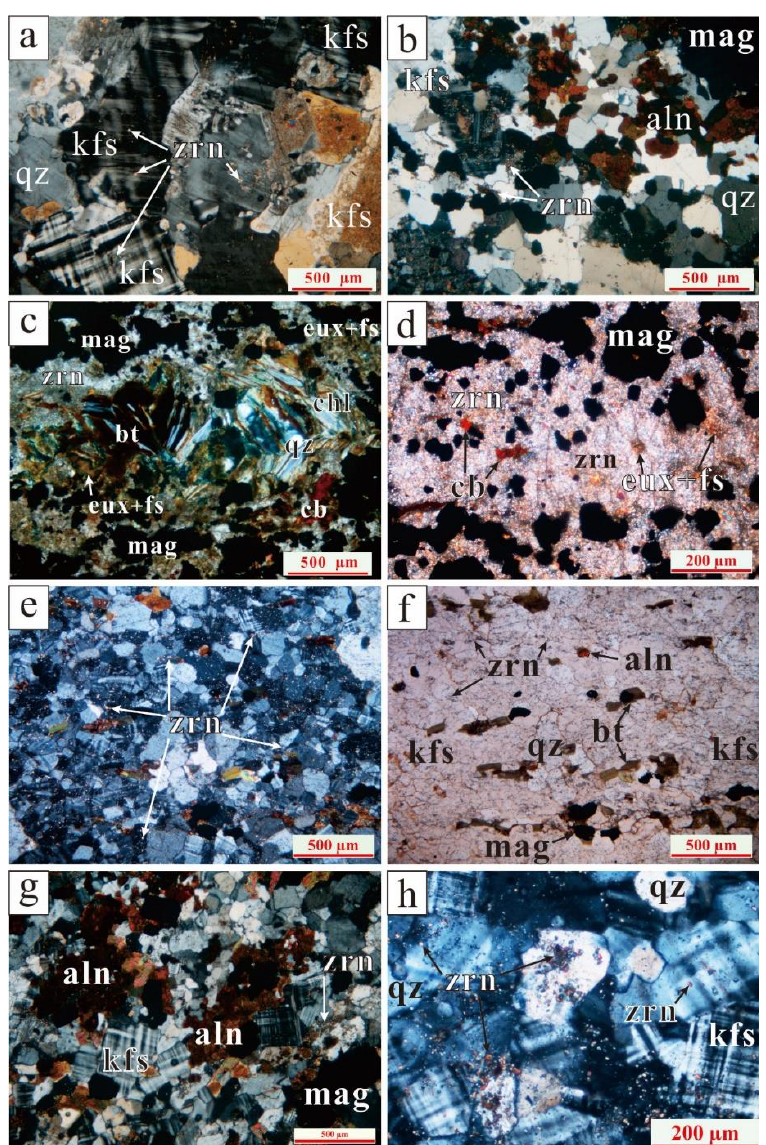
Figure 4. Representative Zr–Nb–Y–REE-enriched alkali rocks from the Chungju deposit. ( a ) Quartz–feldspar-rich layer from layered granite. Zircon occurred as an inclusion within quartz and K-feldspars, and a graphic texture was observed. ( b ) Zircon–allanite–magnetite-rich layer from layered granite. Zircon, allanite, and magnetite were co-precipitated along with quartz and K-feldspar. ( c , d ) Paragenetic association of zircon in a zircon–allanite–magnetite-rich layer. The white-colored regions were mostly composed of zircon aggregates. Note that magnetite grains exhibited various sizes and habits. ( e , f ) Shape preferred orientation of biotite grains, and ubiquitous zircon in layered aplite. ( g ) Alkali aplite comprising allanite aggregates, K-feldspar, magnetite of variable grain size, and microcrystalline zircon. ( h ) Zircon was ubiquitous as inclusions in quartz and K-feldspar grains (poikilitic texture) in alkali aplite. Abbreviations: qz (quartz), kfs (K-feldspar), mag (magnetite), aln (allanite), zrn (zircon), bt (biotite), chl (chlorite), eux (euxenite), fs (fergusonite), cb (columbite).